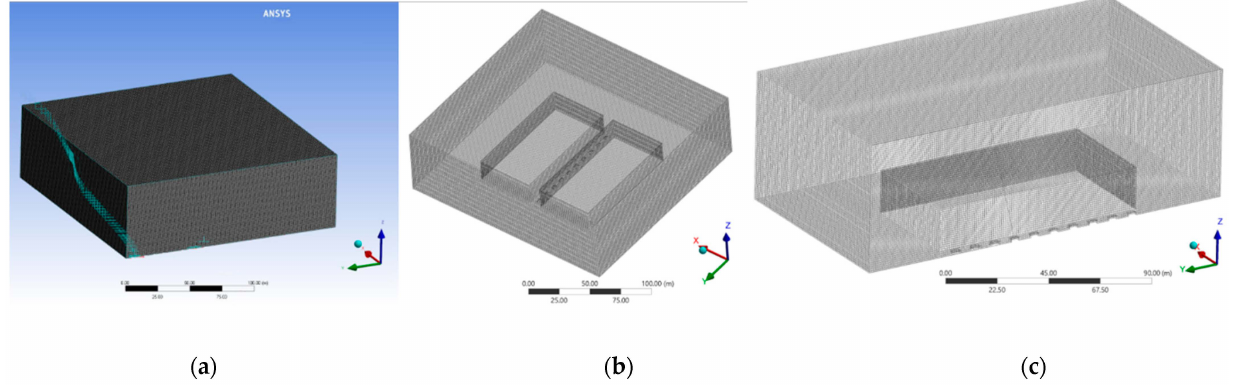
Figure 3. ( a ) Computational domain (dimensions in meters); ( b ) computational grid (720,000 cells); ( c ) grid section of urban